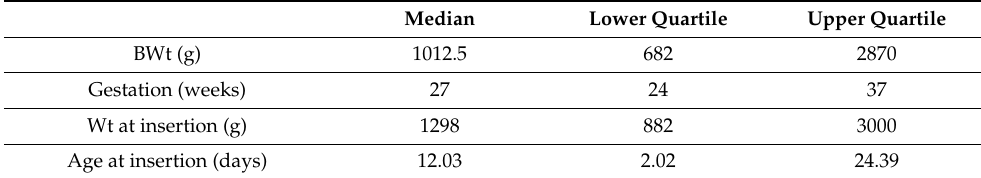
Table 2. Demographics and age of insertion for the whole